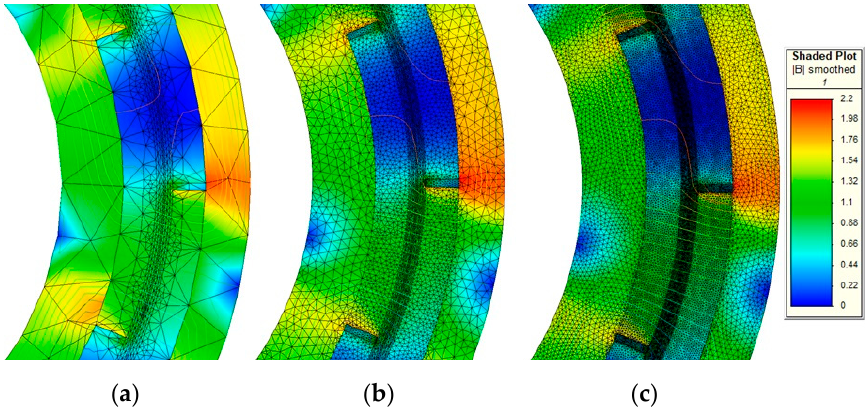
Figure 9. The mesh map with mesh-factor of: ( a ) 10, ( b ) 1, ( c ) 0.5. In terms of solution accuracy, the ‘optimal mesh-factor’ for FEM is identified by de- termining the maximum relative error. In particular, the CMC geometry described in case